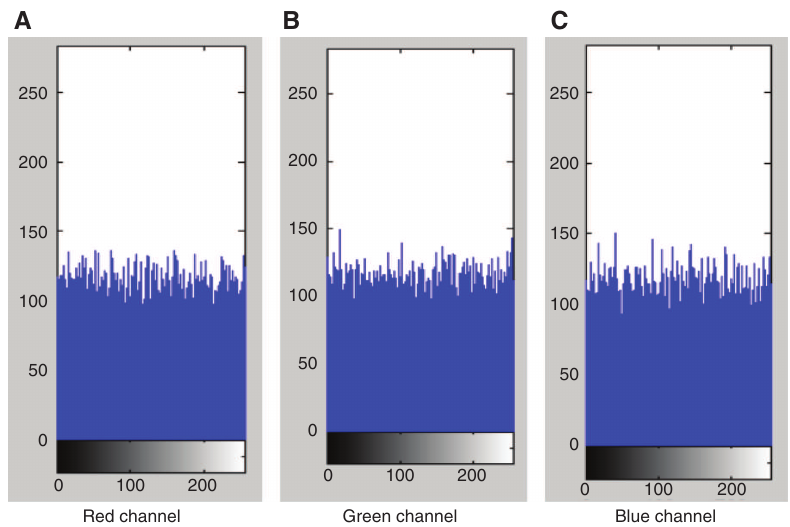
Figure 6: Histogram Distribution of the Encrypted Image.